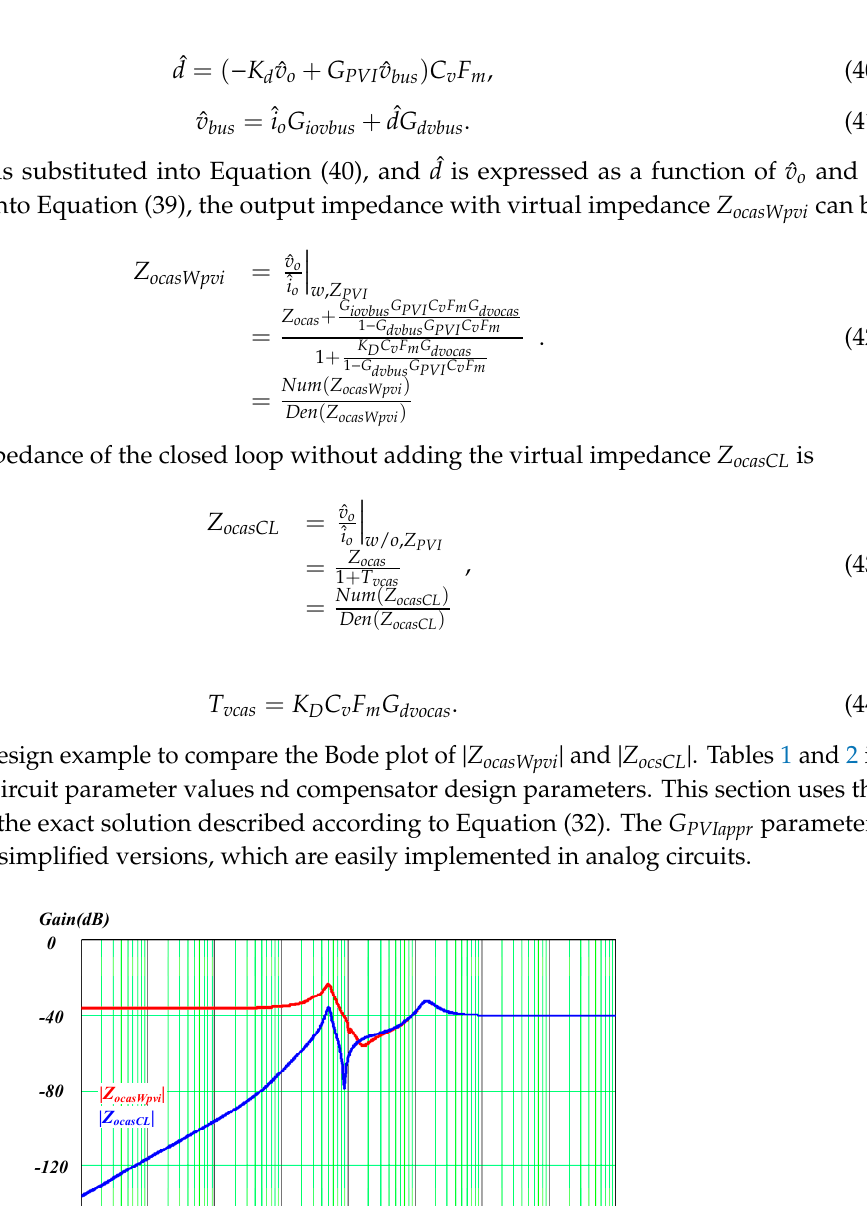
| Z | and | Z ocasWpvi